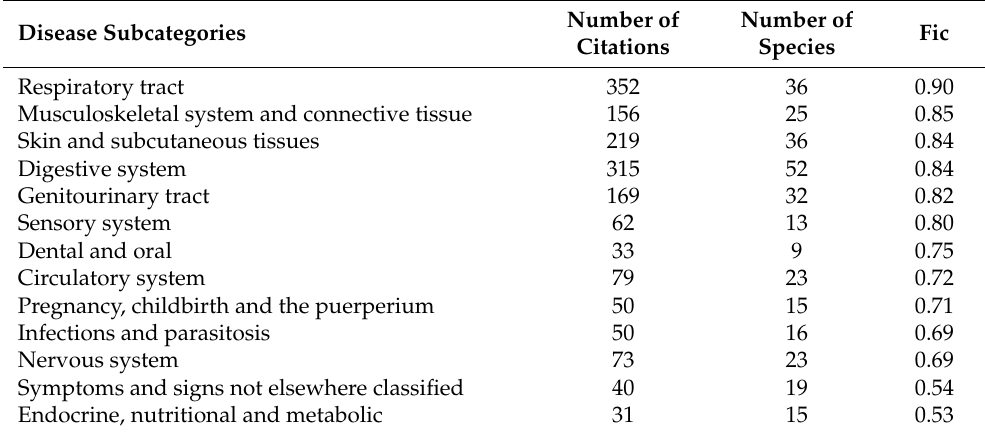
Table 4. Factor informant consensus (Fic) index related to the agreement on species used to treat different